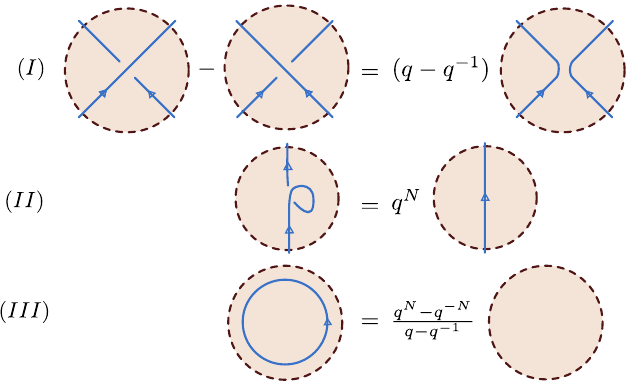
Figure 5 . The skein relations defining Sk( M, gl ( N )) for links in blackboard framing.